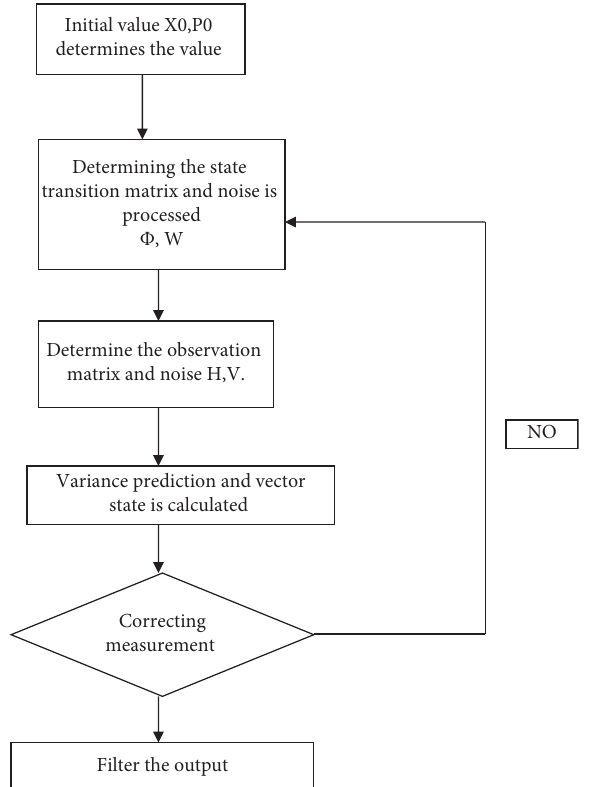
Figure 3: Flow chart for sensor data